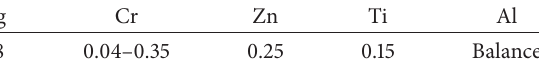
cast from stir casting p